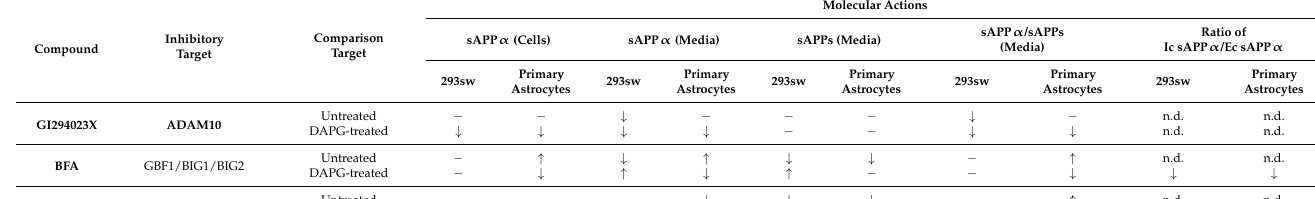
Table 3. Summary of changes in sAPPs parameters by GI293023X, BFA, or GCA alone and co- treatment with DAPG. Changes are shown compared to untreated cells (untreated) and DAPG-treated cells (DAPG-treated), respectively (Ic, intracellular; Ec, extracellular; n.d., not determined).